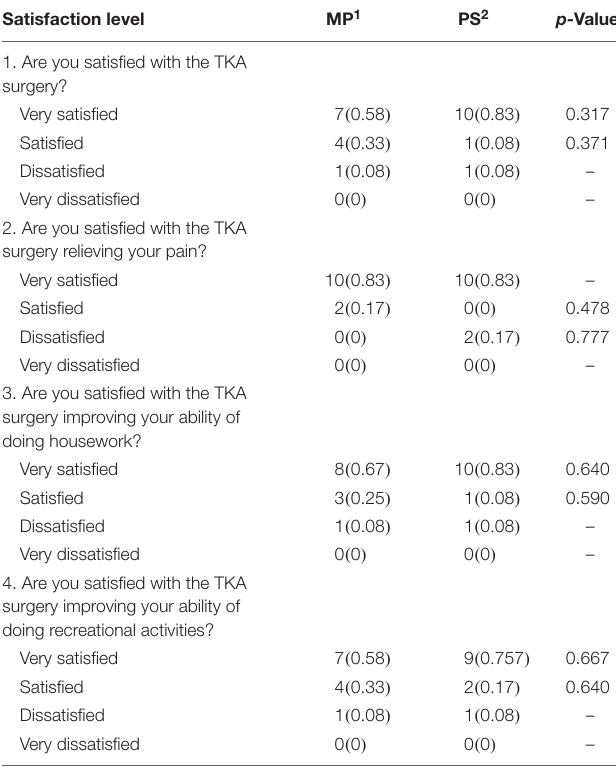
Frontiers in Bioengineering and Biotechnology |